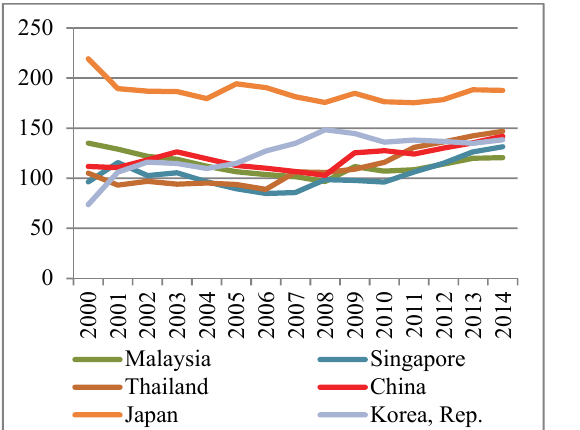
Fig. 1. Domestic credit to private sector in more developed financial systems (% of GDP)